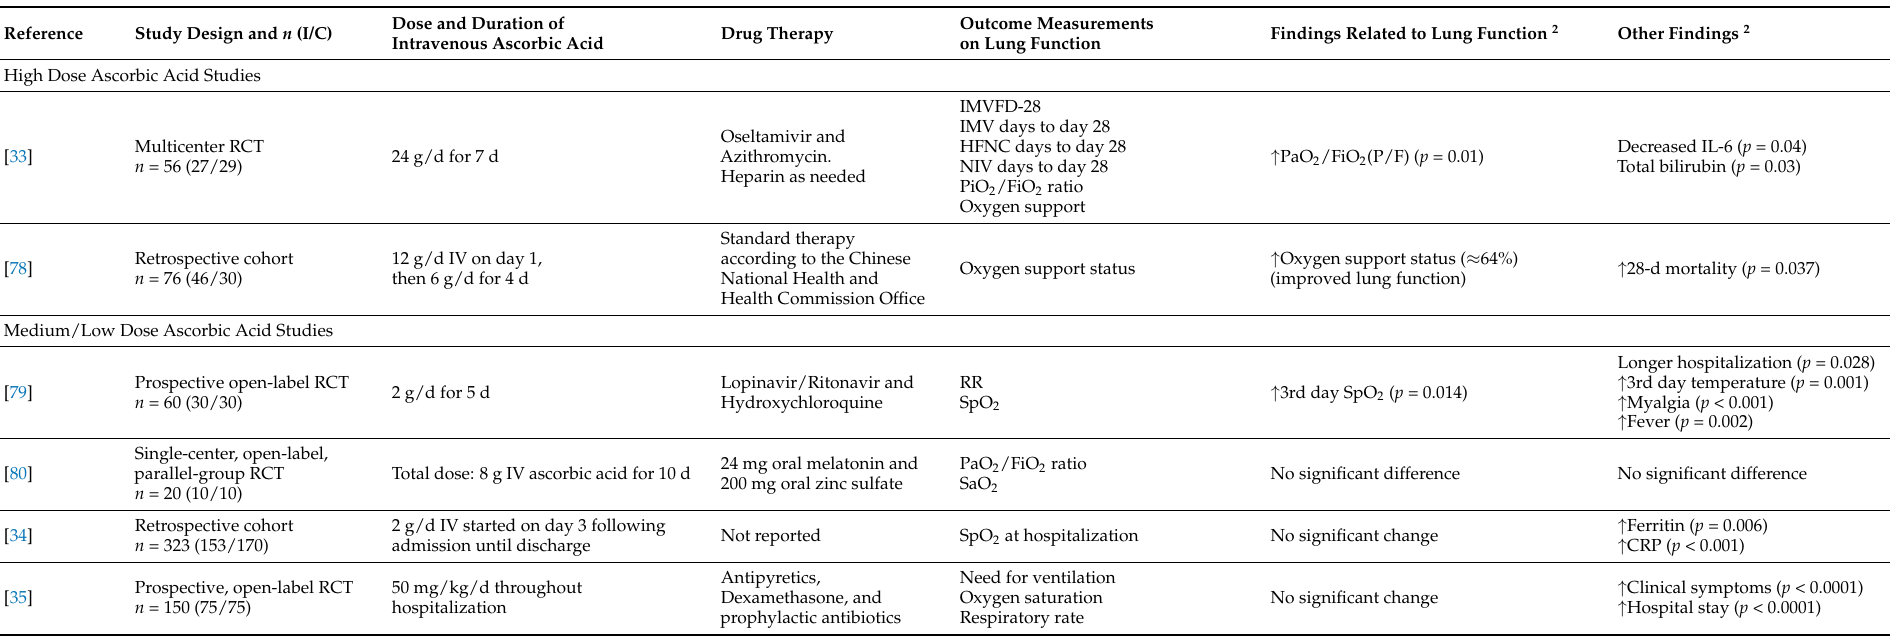
Table 1. Summary of human clinical trials investigating the effect of high-dose intravenous ascorbic acid on lung function markers of patients with severe COVID-19 infection 1